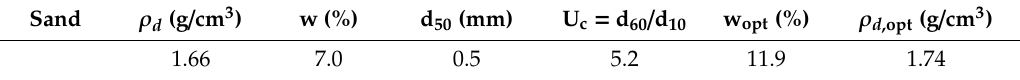
Figure 1. A particle size distribution curve of the sand used in this study. Table 1. Parameters of the sand used to fill the box.